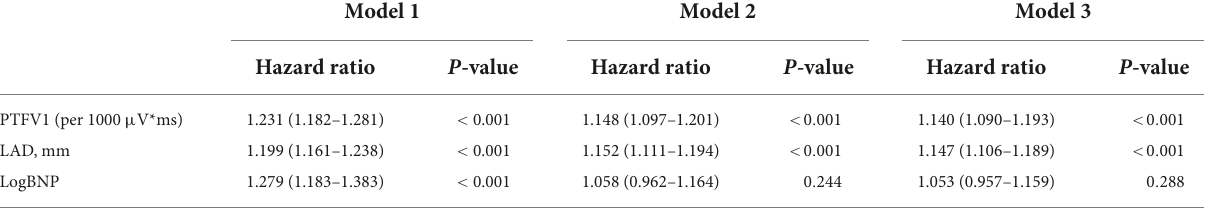
TABLE 2 The relationship between ACM markers and ICVE.